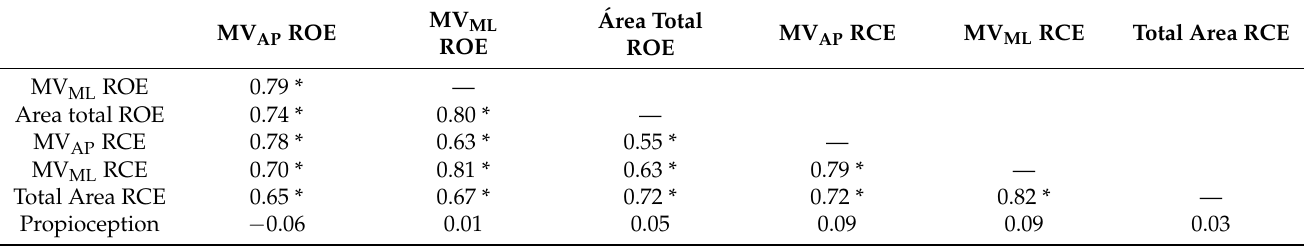
Table 2. Correlation coefficients between proprioception and postural control with eyes open and closed.